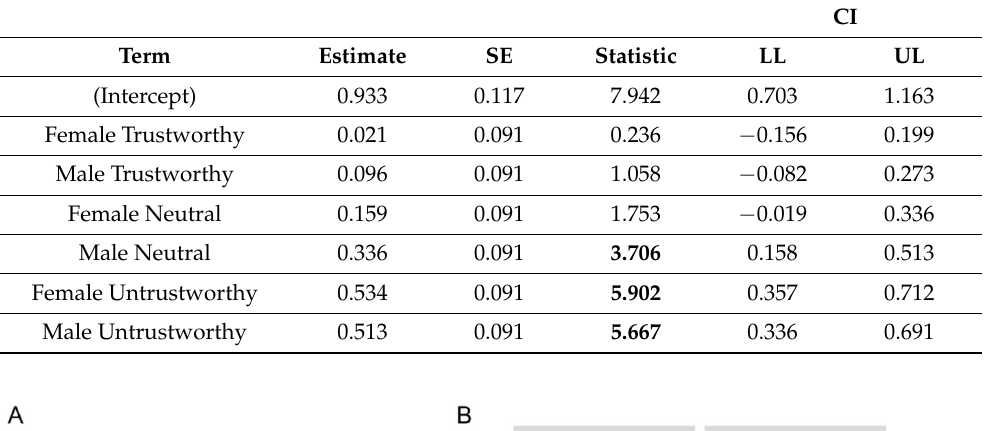
Table 5. Results of lmm on h parameter (log scale). SE is the same for each level of proposer because the data are balanced. CI = 95%. LL = lower level. UP = upper level. Significant statistics (t as z criterion) are reported in bold.